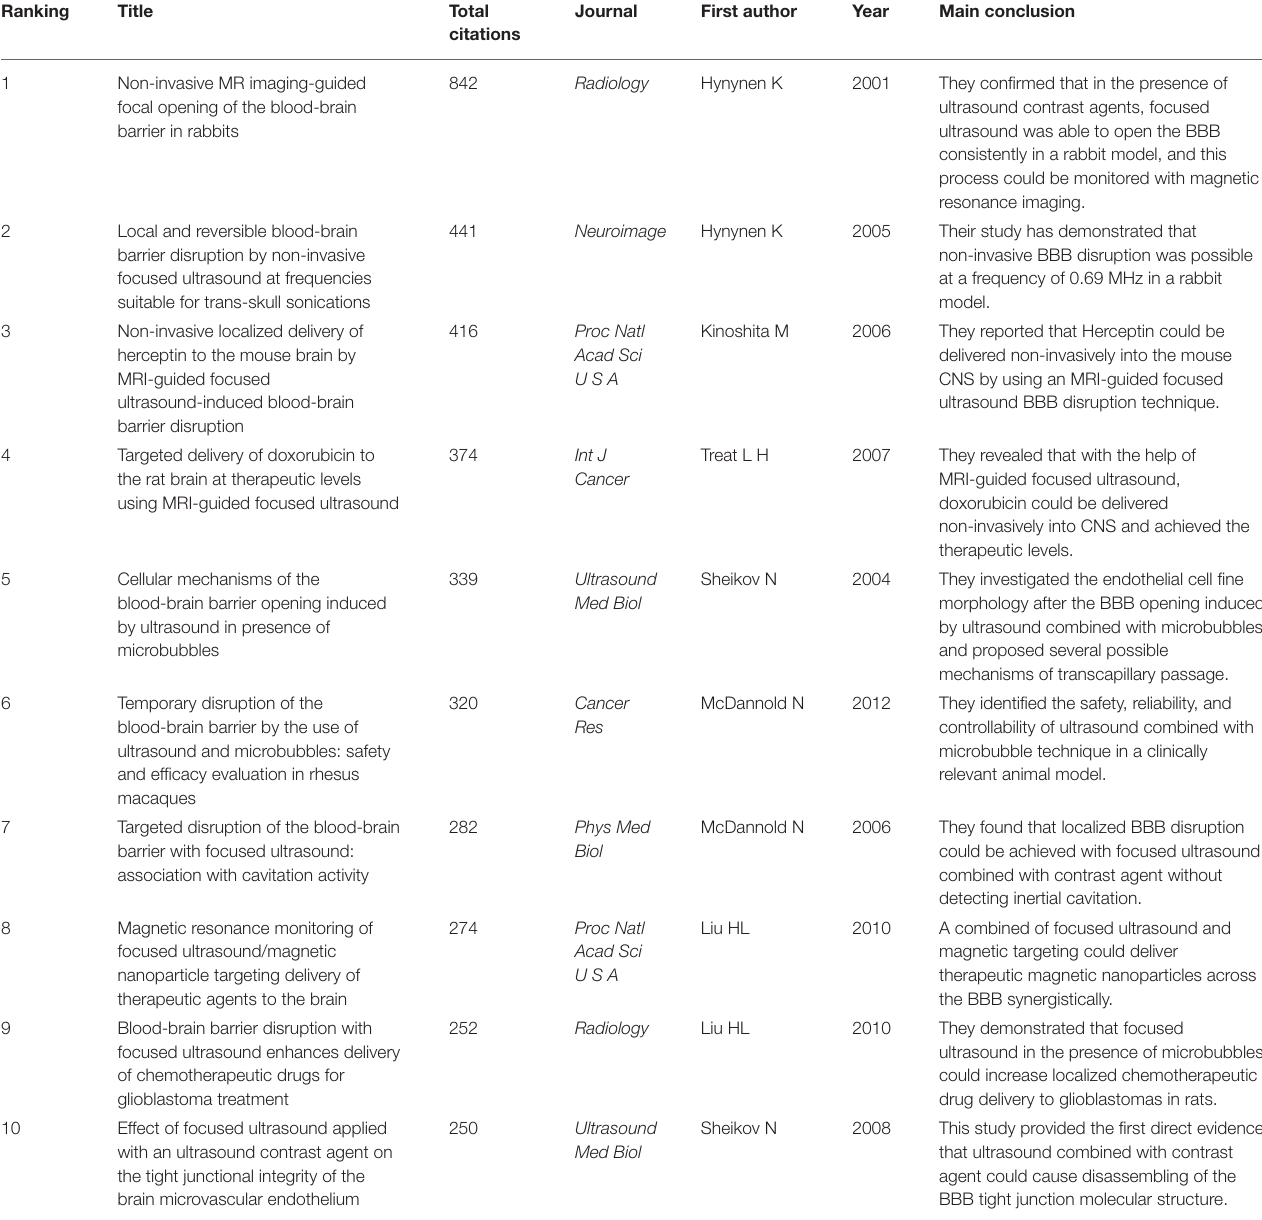
TABLE 4 | The top 10 original articles related to ultrasound induced BBB opening with the most